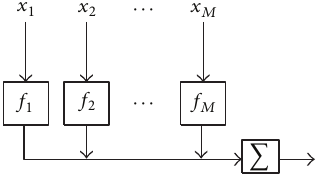
Figure 7: Basic principle of the forgotten